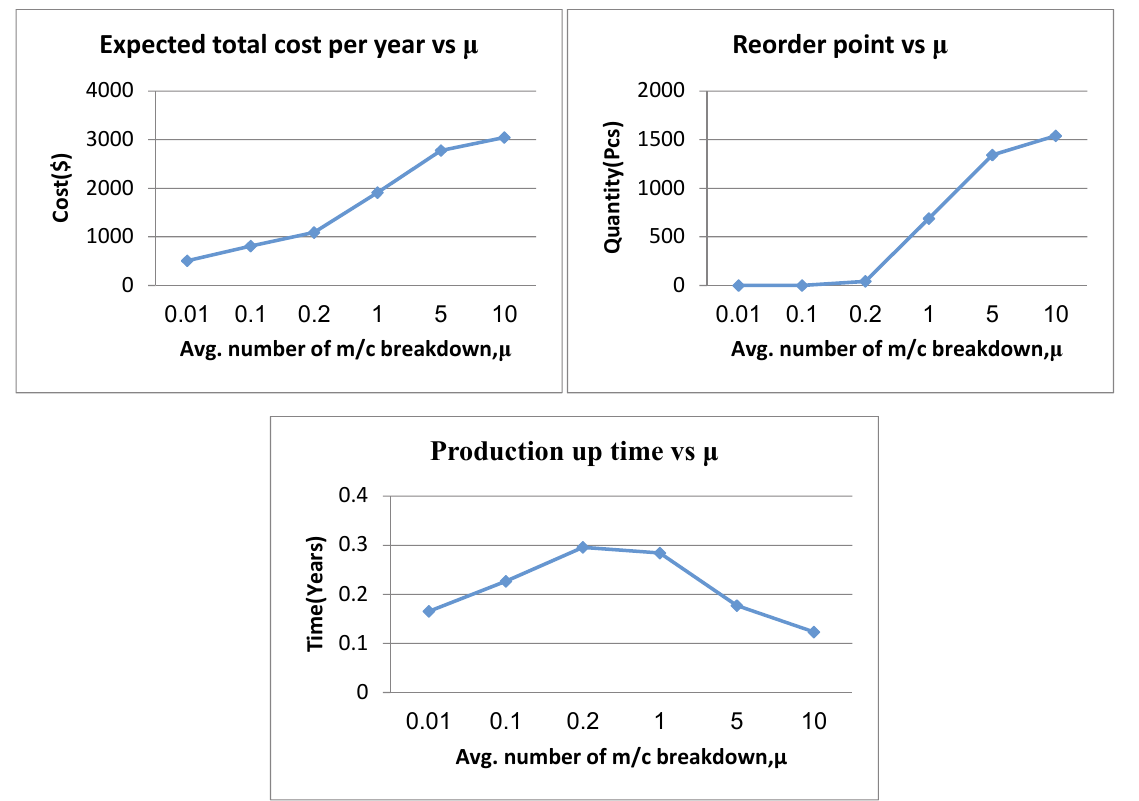
Fig. 12. Expected total cost per year, up time & reorder point for different value of